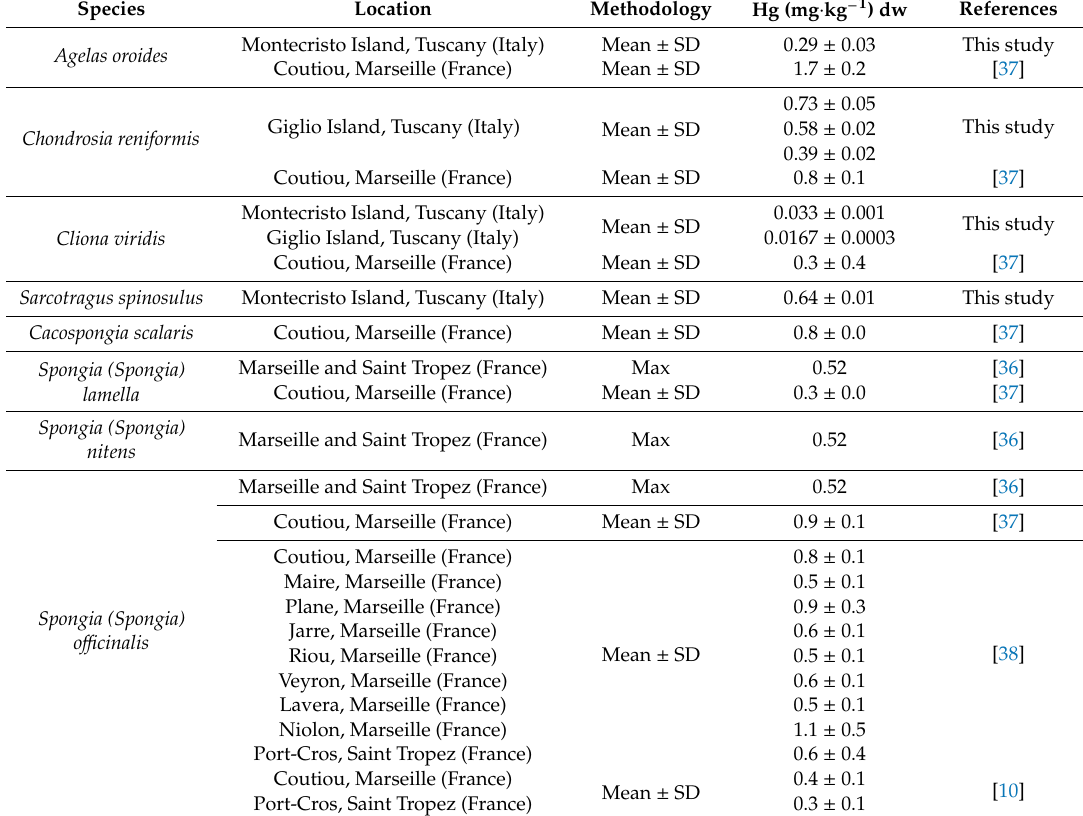
Table 1. Selection of literature data for mercury concentrations in